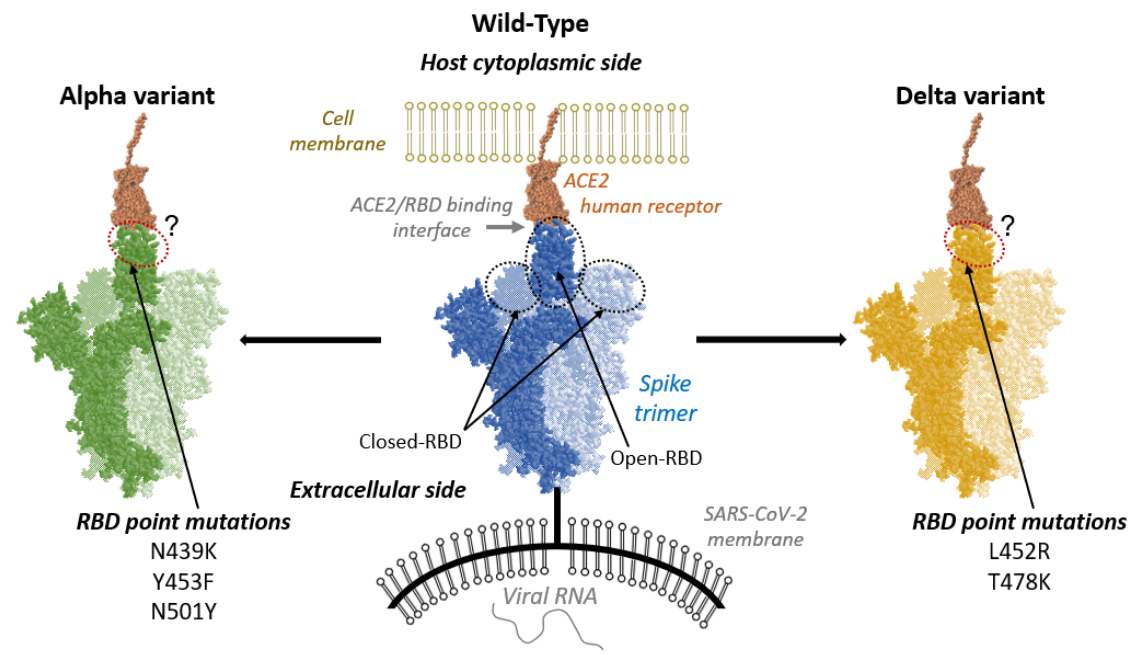
Figure 1. Schematic representation of the interaction between ACE2 receptor (brown) and Spike-RBD (blue: wild-type; green: Alpha variant; orange: Delta variant). In each case, the two light-colored Spike monomers have a RBD in closed conformation, while the dark-colored Spike monomer has a RBD in its open conformation, allowing complexation with ACE2. For both variants the RBD point mutations are listed.